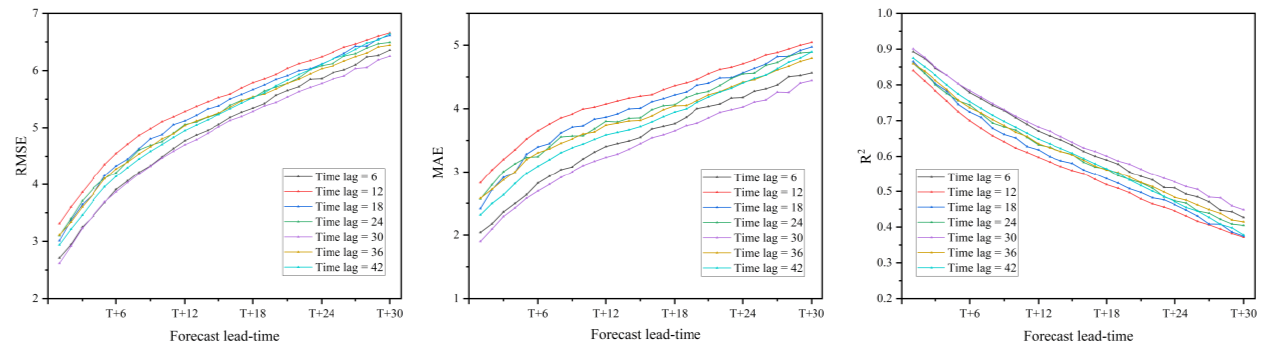
Figure 6. WQI prediction modeling methodology structure.